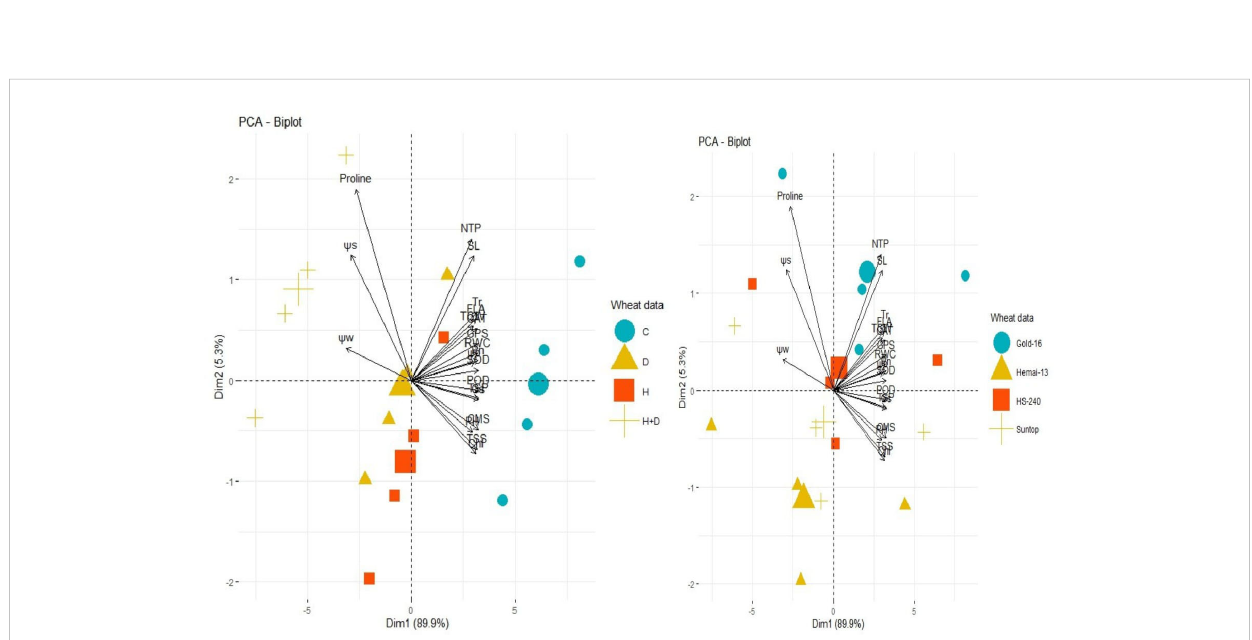
FIGURE 6 Principal component analysis (PCA) vectors demonstrating the effect on the proximity association between biochemical contents, physiological attributes, plant – water relations, and agronomic traits, and wheat cultivars (right) and individual and combined treatments of heat and drought stress (left). Superoxide dismutase (SOD); catalase (CAT); peroxidase (POD); total soluble proteins (TSPs); total soluble sugars (TSSs), photosynthesis rate (Pn); transpiration rate(Tr); cell membrane stability (CMS); stomatal conductance (Gs); water potential (Wp); osmotic potential (Sp); pressure potential (Pp); relative water content (RWC); fl ag leaf area (FLA); plant height (PH); number of tillers per plant (NTP); spike length (SL); number of grains per spike (GPS); and thousand-grain weight